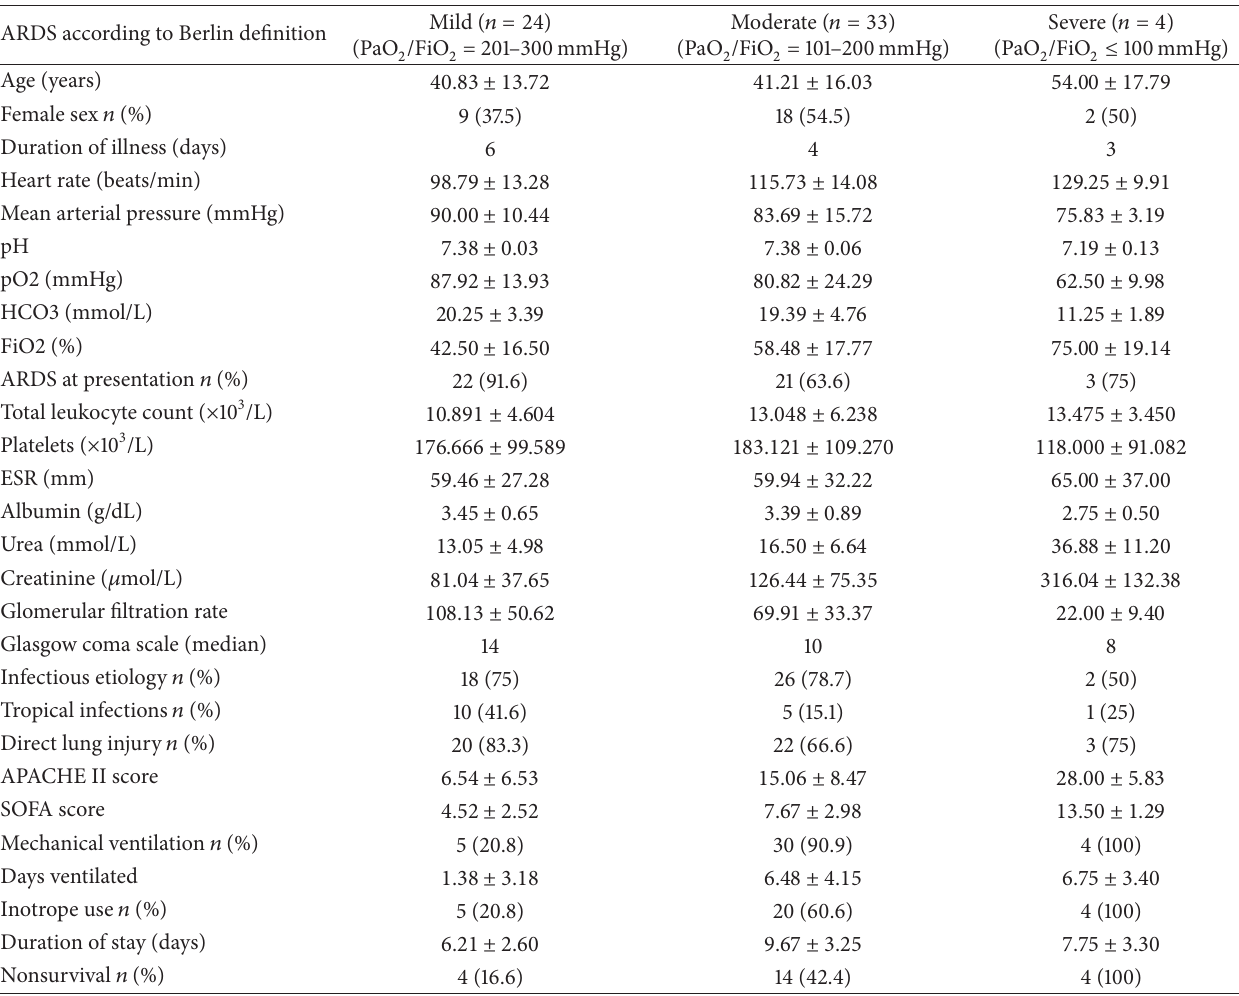
Table2:CharacteristicsofpatientsbasedonBerlindefinition—demographics,laboratoryinvestigations(means),complications,andhospital